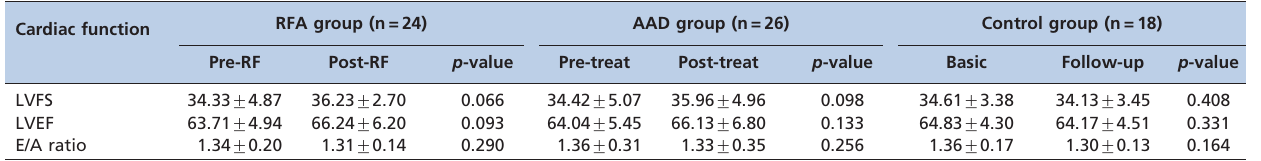
Figure 2 - The absolute change in cardiac cavity diameters in each group. The cavity changes are indicated as absolute changes in the RFA group. Positive changes indicate a reduction in the diameters of the cardiac cavities. * p , 0.01 vs . control group, ‘ p , 0.05 vs . AAD group. RA: right atrium; RV: right ventricle; LA: left atrium; LV: left ventricle; IVS: interventricular septum; LVPW: left ventricular posterior wall; AO: aortic opening; PO: pulmonary artery. Table 3 - Variation of cardiac function in each